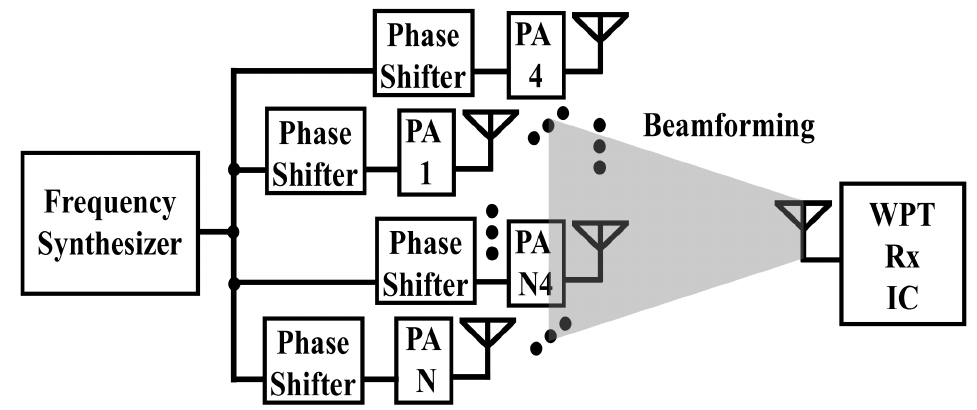
Figure 2. Conventional RF wireless power transfer